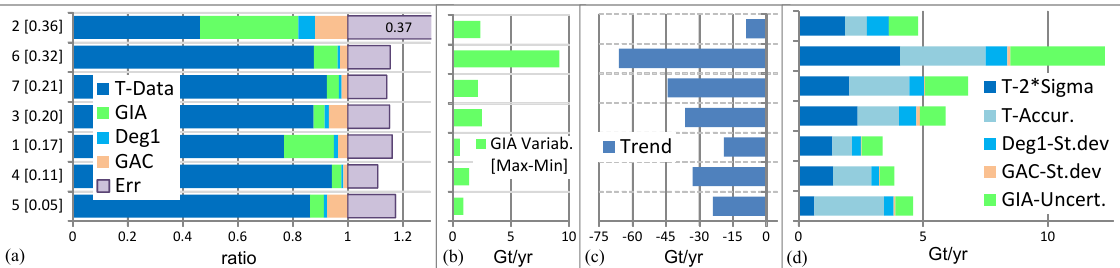
Fig. 9. Trend summary for Greenland with same meaning as in Fig. 8. Table 6. Trends (in Gt yr − 1 ) for Greenland ice sheets’ (GRIS) and for Antarctica ice sheets’ (AIS) three macro regions: Antarctic Peninsula (AP), West (WA) and East Antarctica (EA).